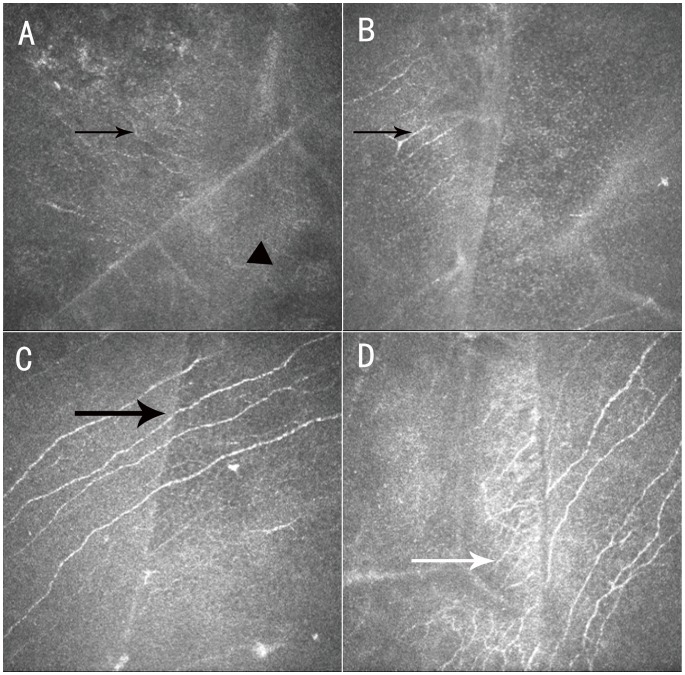
Confocal microscopy (HRT III) images showing nerve regeneration at the flap margins after FS-LASIK.At postoperative 1-week visit (A), subbasal nerve fibers were only noted outside the flap (black arrow), but not inside the flap (▴). At the 1-month visit (B), discrete subbasal nerve fibers were visible within the flap area (black arrow). At the 3-month visit (C), obvious subbasal nerve fibers with thick and regular appearance were seen (black arrow). At the 6-month visit (D), a lot of small-caliber nerve fibers with obvious tortuosity and loops were noted inside the flap (white arrow) (images acquired from the same subject). Field size: 400 µm×400 µm.